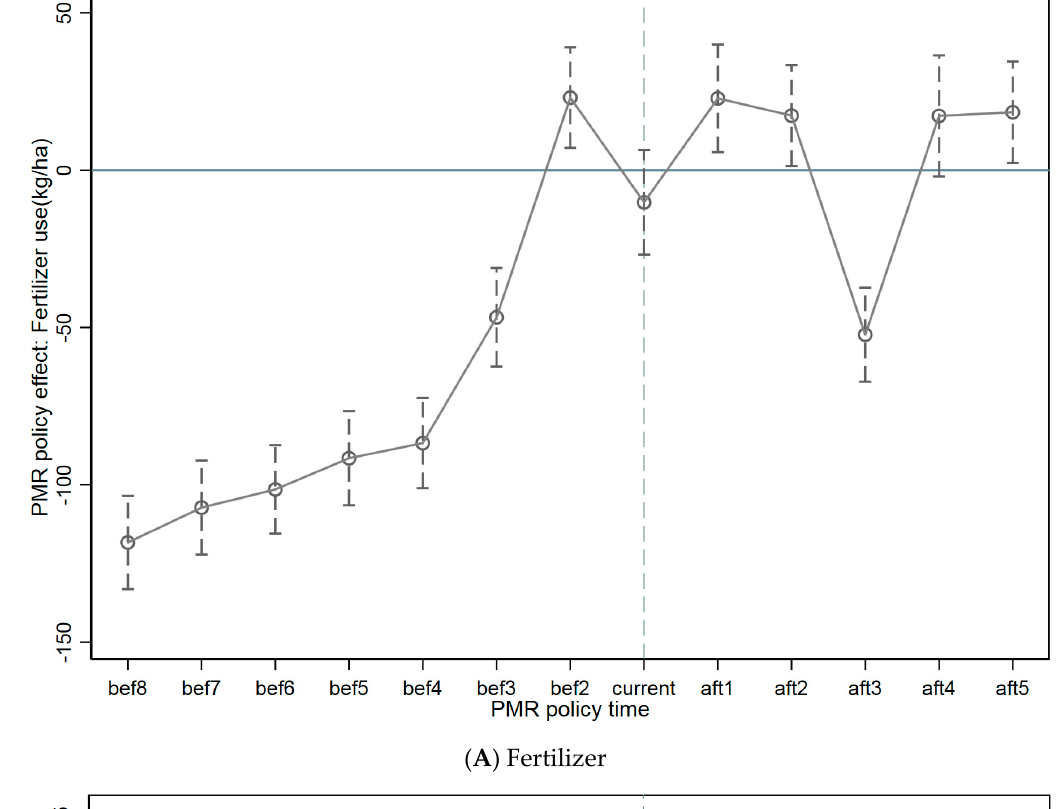
Figure A2. Parallel trends of the PMW program for ( A ) Fertilizer and ( B ) Pesticides; In kg/ha; For a 95% confidence interval. Source: Calculated from the RFOP survey data set 1997–2010.